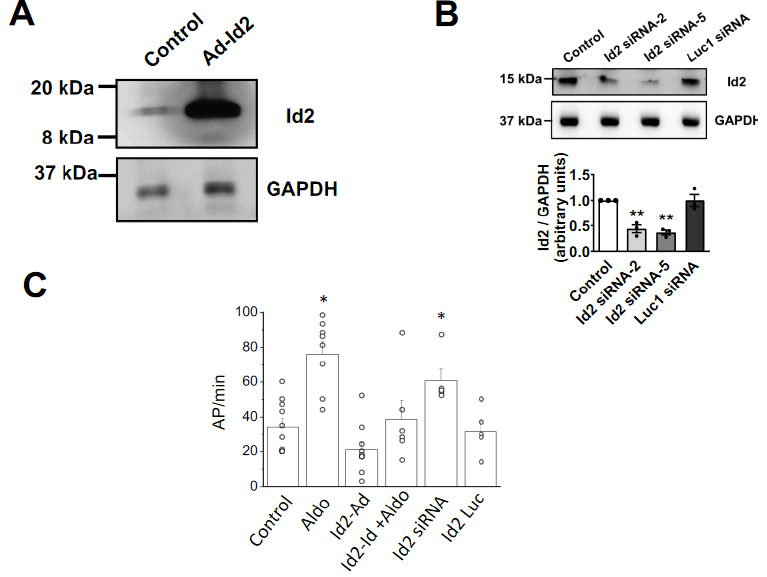
Figure 2. Effects of Id2 overexpression and siRNA knockdown on cardiomyocytes spontaneous action potential rate. ( A ) Id2 overexpression was achieved after 24 h transduction with adenoviral vector. Pictures of western blot experiments showing the Id2 protein (upper) and GAPDH protein (lower) expression levels in neonatal rat ventricular cardiomyocytes. ( B ) Id2 expression was knock down with siRNA. siRNAs were transfected for 48 h and proteins were extracted. Representative pictures of western blot experiments showing the Id2 protein (upper) and GAPDH protein (lower) expression levels in neonatal rat ventricular cardiomyocytes in control, Id2 targeting siRNA, and Luciferase (Luc) targeting siRNA. Bar graph are the mean of n = 3 independent experiments. ( C ) Bar graph shows the number of spontaneous action potential per min in control, aldosterone treated (1 µmol/L), Id2 overexpressing, Id2 overexpressing with aldosterone (1 µmol/L), Id2 siRNA, and Luc1 siRNA cardiomyocytes. The data were evaluated by one-way analysis of variance (ANOVA) followed by Tukey–Kramer’s post hoc test. Bar graphs are mean and + s.e.m, * p < 0.05, ** p < 0.01